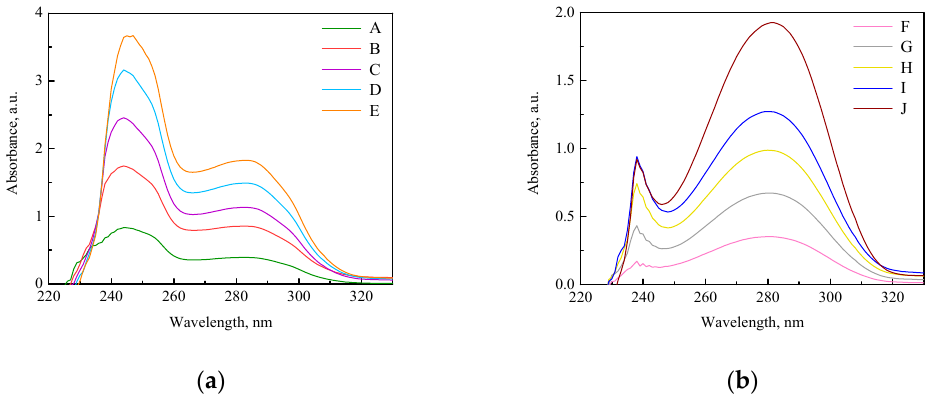
Figure 5. UV–Vis absorption of ternary solutions based on Ecoflex ® ( a ) and L,D-PLA ( b ) where A–E is Ecoflex:5CB:SWCN: (A) c (concentration) = 15.2 mg/dm 3 :c = 2.3 mg/dm 3 :c = 8.7 mg/dm 3 ; (B) c = 30.3 mg/dm 3 :c = 4.5 mg/dm 3 :c = 17.3 mg/dm 3 ; (C) c = 45.5 mg/dm 3 :c = 6.8 mg/dm 3 :c = 26.0 mg/dm 3 ; (D) c =